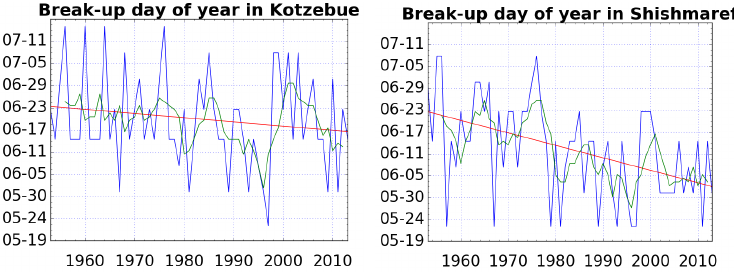
Figure 4. Trends in break-up day of year for Kotzebue and Shishmaref. Blue line is yearly break-up day, and green line indicates the 5-year running mean. Data are from HSIA.